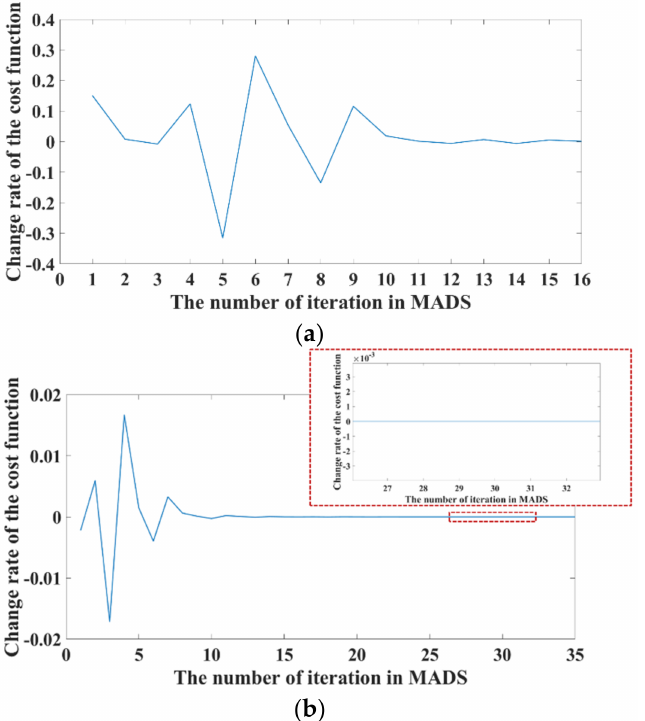
Figure 6. Comparison of change rate at global optimum and robust optimum: ( a ) change rate of the cost function at global optimum; ( b ) change rate of the cost function at robust optimum. The results indicate that the average number of function calls for RPSO was 4172.4. In contrast, for ePSO and RePSO, the average number of function calls were 763.2 and 796.2, respectively. This shows that ePSO and RePSO exhibit superior performance compared to RPSO in terms of the solution searching speed. In addition, RePSO achieved the best result when searching for a robust solution. RePSO searched for the robust solution